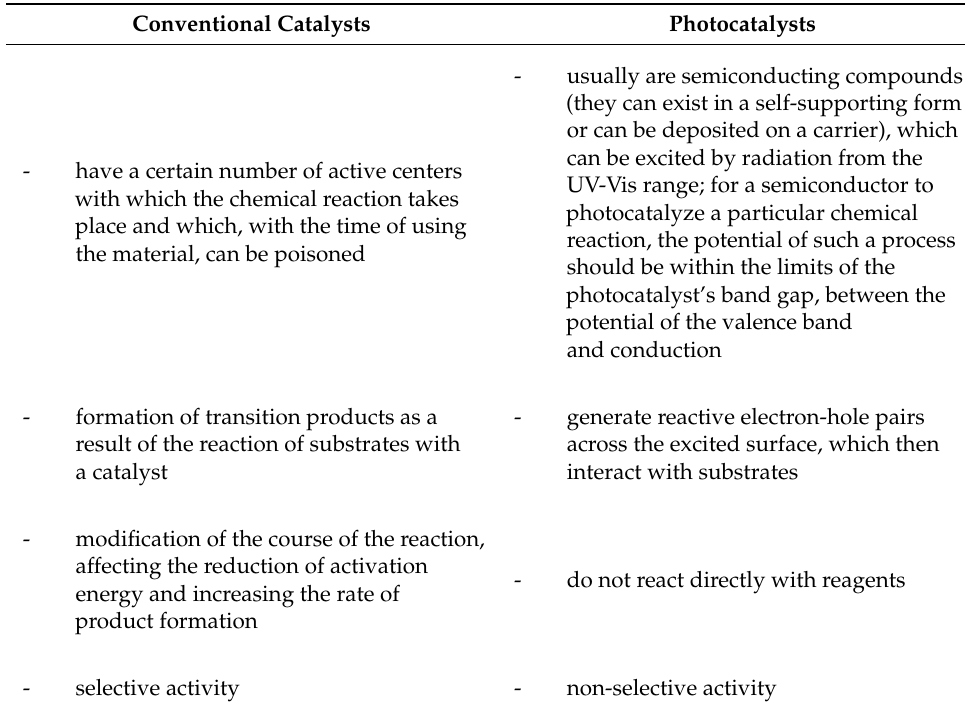
Table 1. Comparison of the properties of traditional catalysts with photocatalysts